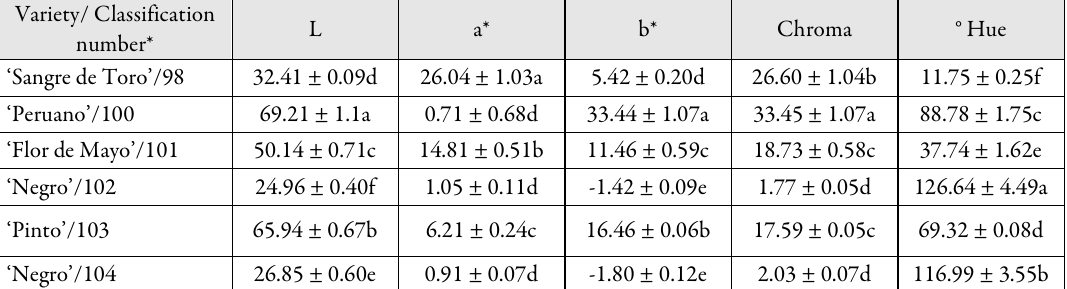
Table 3. Seed color characteristics of several common bean varieties from Morelos State, Mexico Variety/ Classification L number*